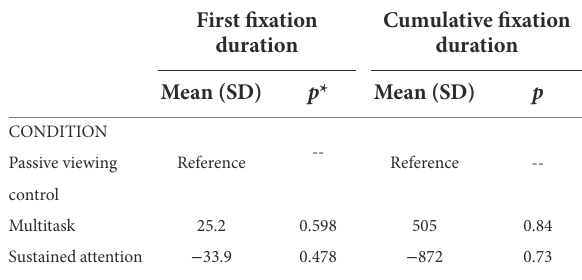
TABLE 1 Unadjusted linear models predicting first fixation duration and cumulative fixation duration from